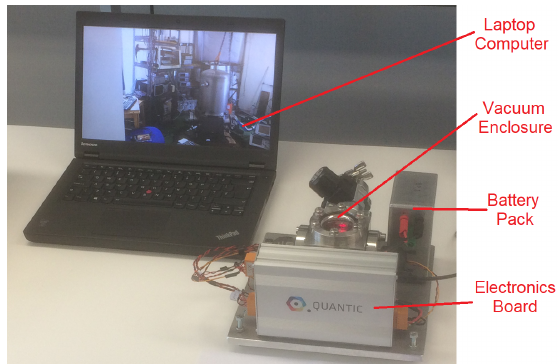
Figure 2. An image of the miniaturised version of the apparatus seen in Figure 1. This device consists of a small vacuum enclosure and an electronics board to control the temperature of the MEMS and process the output signal. Both are mounted on a plate that can be used to adjust the tilt of